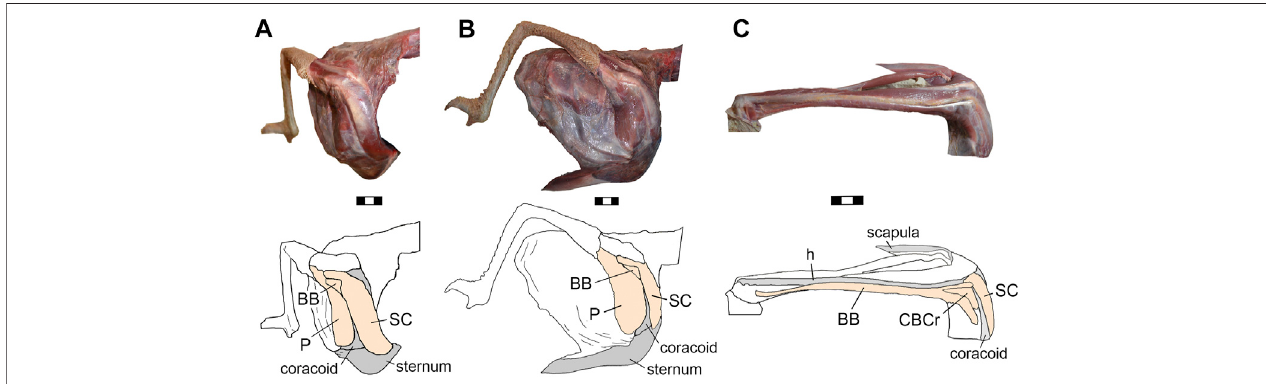
FIGURE 2 | Rhea americana , photographs and schematic drawings of selected muscles of right shoulder girdle in anterolateral (A) and lateral (B) views, and proximal humerus in lateral (C) view. Abbreviations. h, humerus; BB, m. biceps brachii ; CBCr, m. coracobrachialis cranialis ; P, m. pectoralis ; SC, m. supracoracoideus . The bones were shaded in gray and the muscles in orange. Scale bars 3